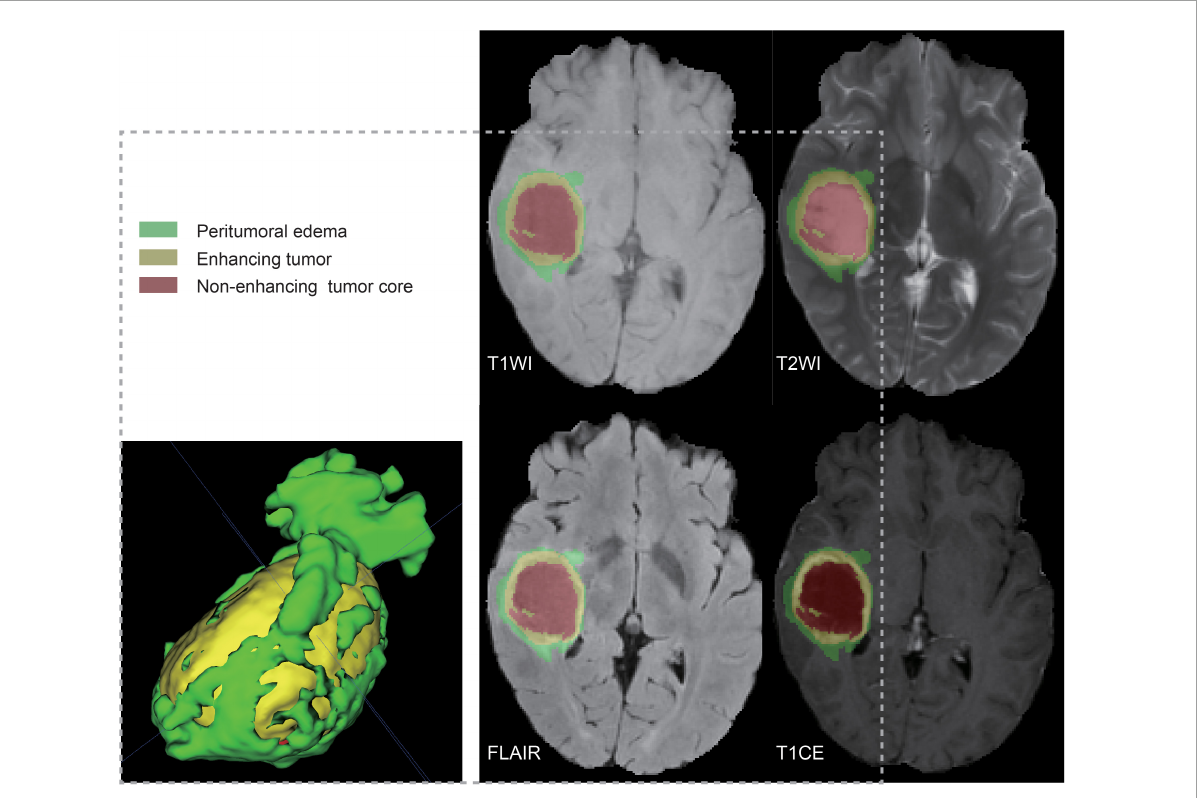
FIGURE1 Ground truth whole-tumor masks. Red voxels represent non-enhancing tumor core; yellow voxels, enhancing tumor; and green voxels, peritumoral